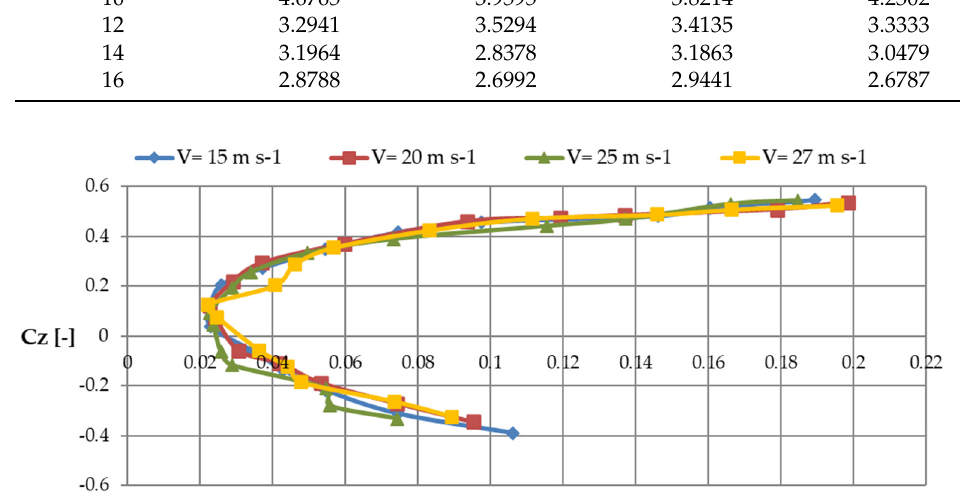
Figure 14. Summary plot of the polar characteristics, Cz = f(Cx), for model M-346 for all tested airflow velocities.